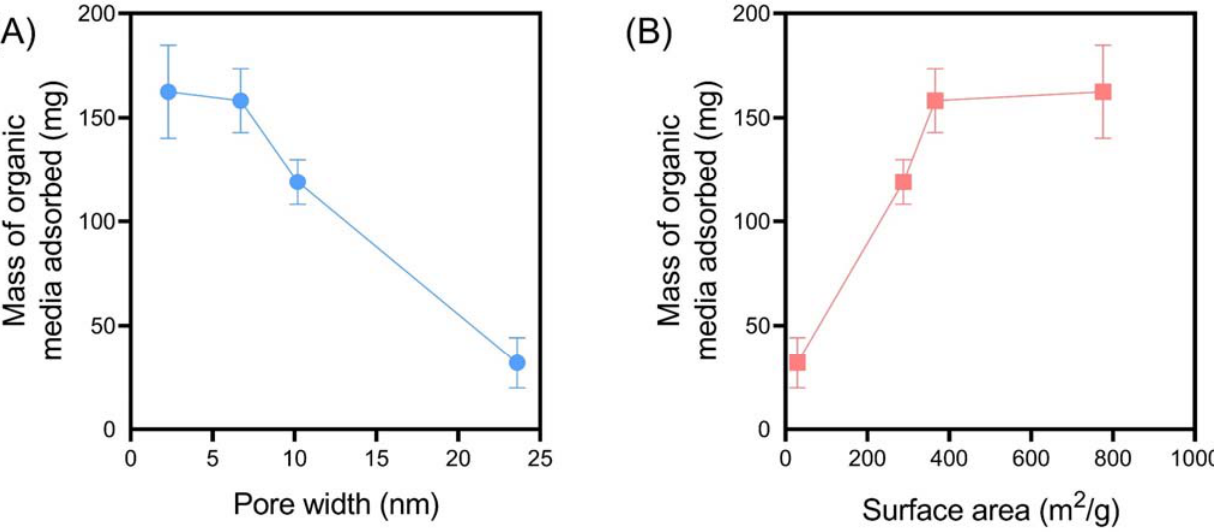
Figure 4. The impact of silica ( A ) pore size and ( B ) surface area on the extent of organic media adsorption at the completion of in vitro digestion studies for PSM, quantified using TGA. Data represent mean ± S.D. ( n = 3).